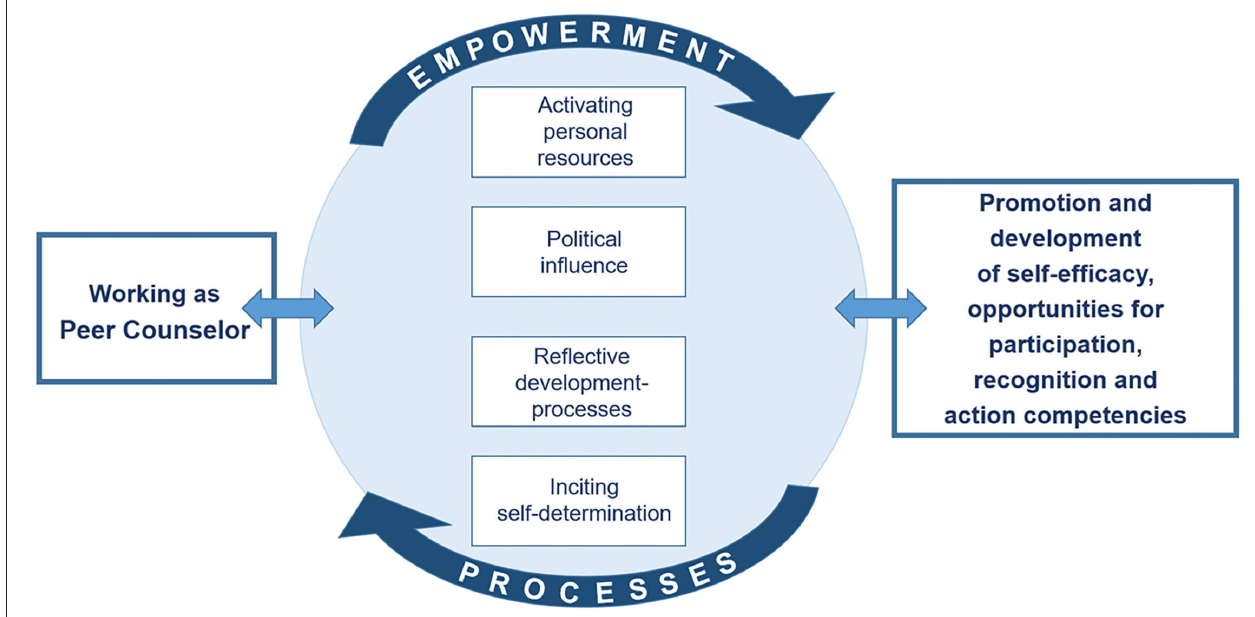
FIGURE 3 | Circle of empowerment in Peer Counseling. Shown here is a circle which contains four terms in rectangles. From top to bottom: “Activating personal resources,” “Political influence,” “Reflective development-processes,” and “Inciting self-determination.” Above this circle, is an arrow in which “Empowerment“ is written—pointing clockwise, and below, the arrow picks up the direction with the word “Process.” To the left (on 9 o’clock), next to the circle, is a rectangle that reads “Working as a Peer Counselor.” On the opposite side, at 3 o’clock, it reads “Promotion and development of self-efficacy, opportunities for participation, recognition and action